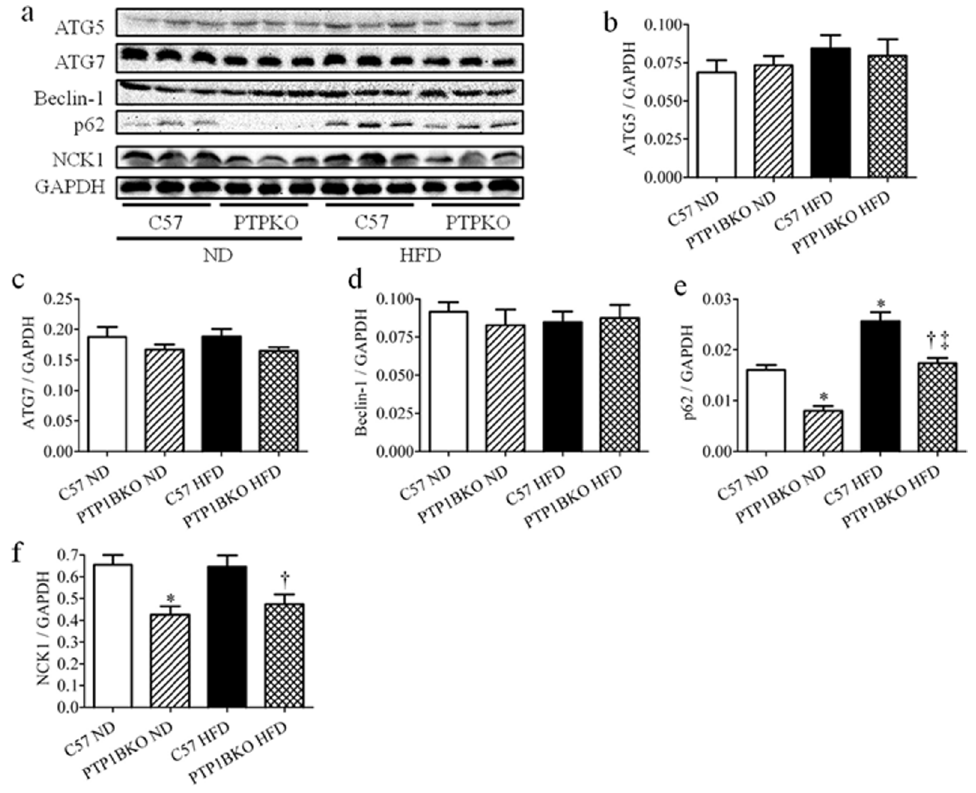
Figure 4. The effect of PTP1B deletion on autophagic flux and NCK1 expression in skeletal muscle of obese mice. Representative Western blots (a) and densitometric analysis (n=6) of ATG5 (b), ATG7 (c), Beclin-1 (d), p62 (e), and NCK1 (f) protein levels in gastrocnemius muscles of the C57 or PTP1BKO mice received normal (ND) or high-fat content (HFD) diets for 20 weeks. * p , 0.05 compared with C57 ND mice, { p , 0.05 compared with C57 HFD mice, ` p , 0.05 compared with PTP1BKO ND mice.